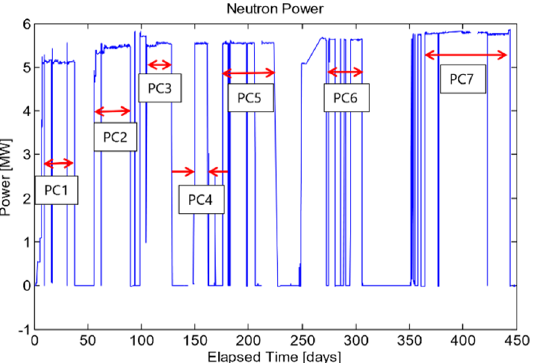
Figure 6. Plot of neutron power vs. elapsed time. PC# represents a full power cycle for which the neutron power remained relatively constant [14].